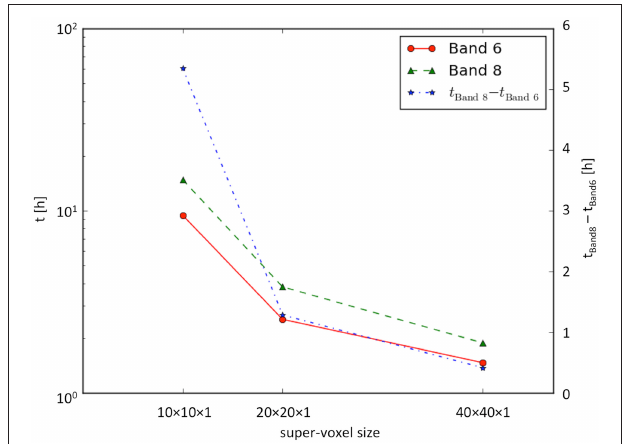
FIGURE 8 | Runtime measurements. Runtime as a function of the super-voxel dimension for the series expansion up to the 6th and the 8th band. Note, that the left time axis is scaled logarithmically, while the right time axis is scaled